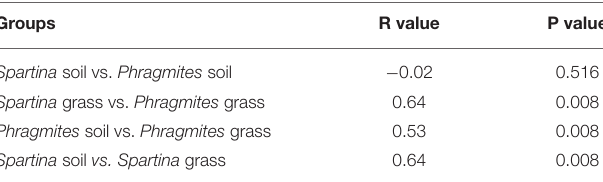
TABLE 1 | Pairwise comparisons for the heavy metal concentrations between the marsh grasses and marsh soils. Groups R value P